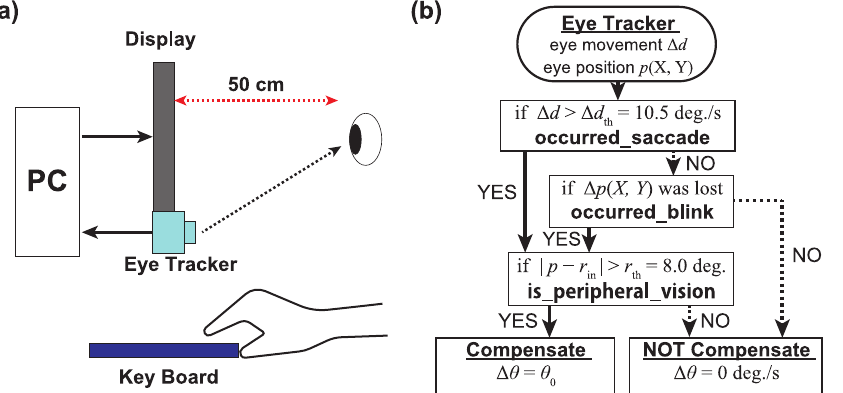
Fig 2. Proposed system and algorithm. (a) Schematic diagram of dynamic perceptive compensation system including an eye tracker for measuring eye movement, a PC with an image-processing device, a display for presenting the images, and a keyboard for subjects to enter their response. (b) Compensation algorithm applied to the RSI as the eye tracker detected saccades or blinks. Only the disk of RSI whose center existed in the peripheral visual field was rotated, with an angular velocity Δ θ during the time Δ t , to reduce the illusory